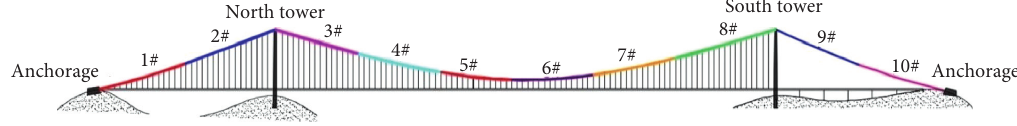
Figure 5: Main cable sectors of the Xihoumen Bridge. Table 3: Dead load effects.